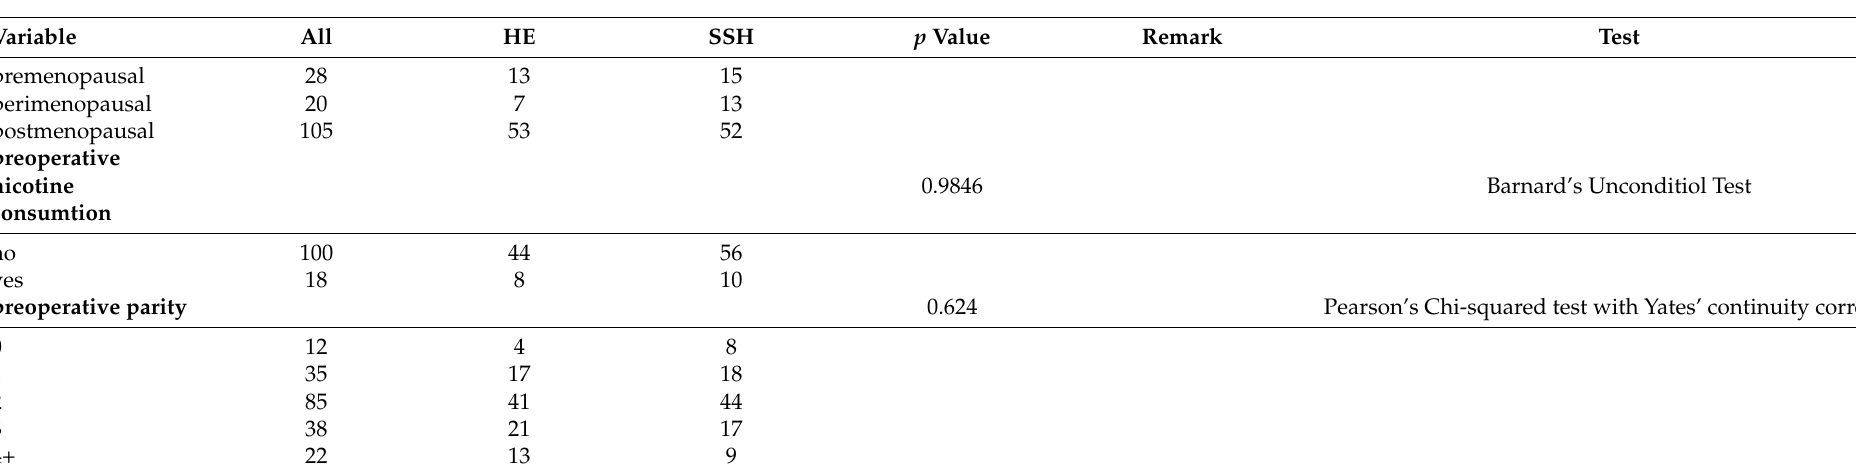
Table 1. Patients’ baseline